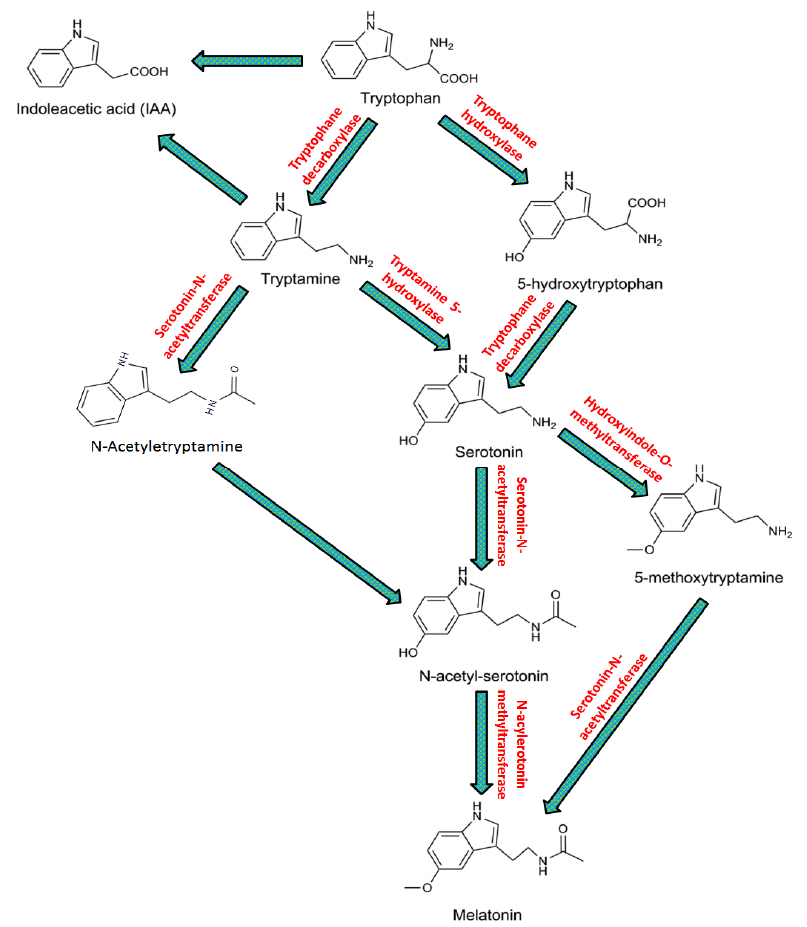
Figure 1. Biosynthesis of melatonin in plants. Modified from Zhang et al. [62].